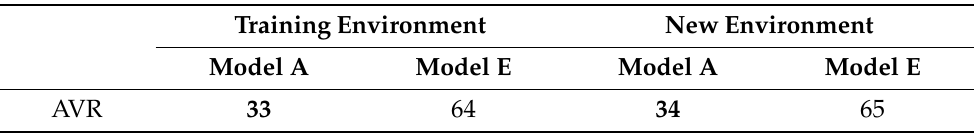
Table 1. Average violation rate (AVR) of red traffic lights in % for the multi-task network with (Model A) and without (Model E) the auxiliary task.